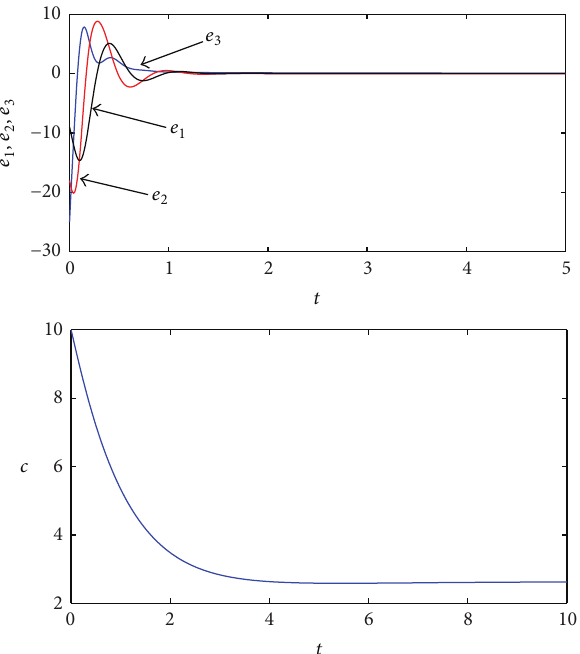
Figure 4: Simulation results of the adaptive synchronization for the fractional-order Lorenz chaotic